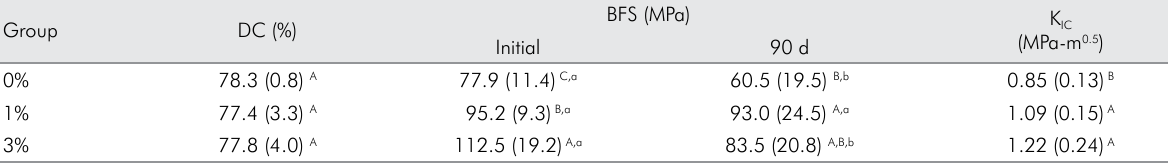
Table 2. Means and standard deviations for degree of conversion (DC), biaxial flexural strength (BFS, initial and after 90 d aging in water) and fracture toughness (K ), as a function of silane content. Similar uppercase letters in the same column and lowercase IC letters in the same line for BFS indicate lack of statistically significant differences among the groups (p > 0.05).